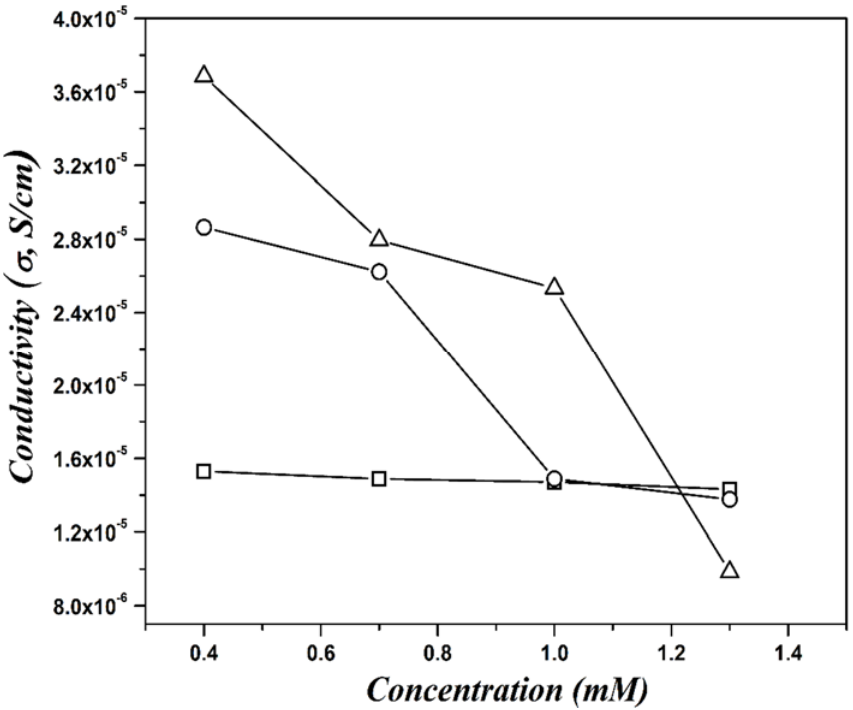
Figure 7. Electrical conductivity of PVA films with self ‐ assembled chitosan ‐ AuNPs/SWCNT ‐ COOH nanostructures as a function of the HAuCl 4 ∙ 3H 2 O concentration for different SWCNTs concentrations (wt.%): ( □ ) 0.1, ( ○ ) 0.3 and ( Δ ) 0.5.